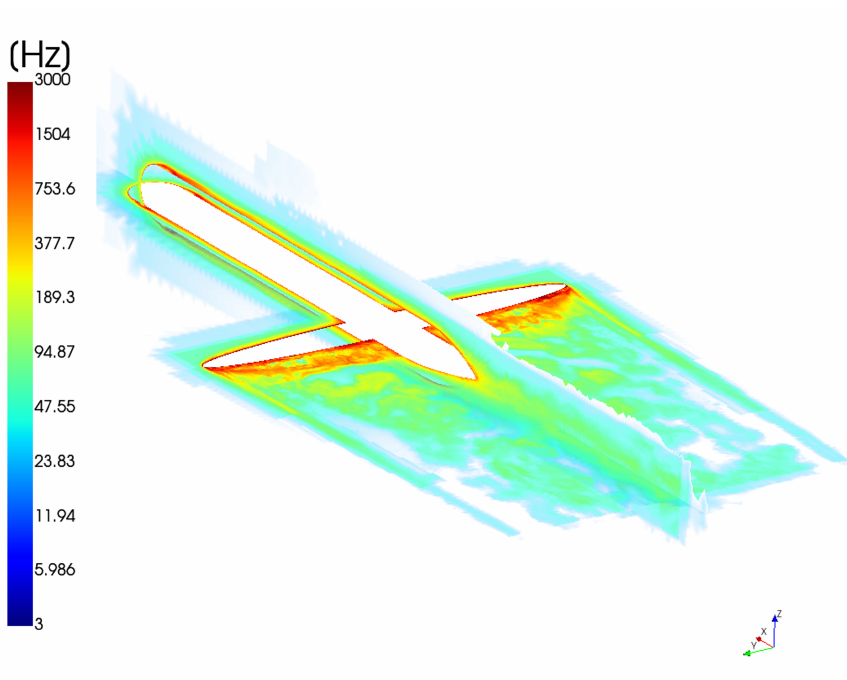
Figure 26. Mesh frequency cut-off of steady hydrofoil VOF solution with coarse mesh.